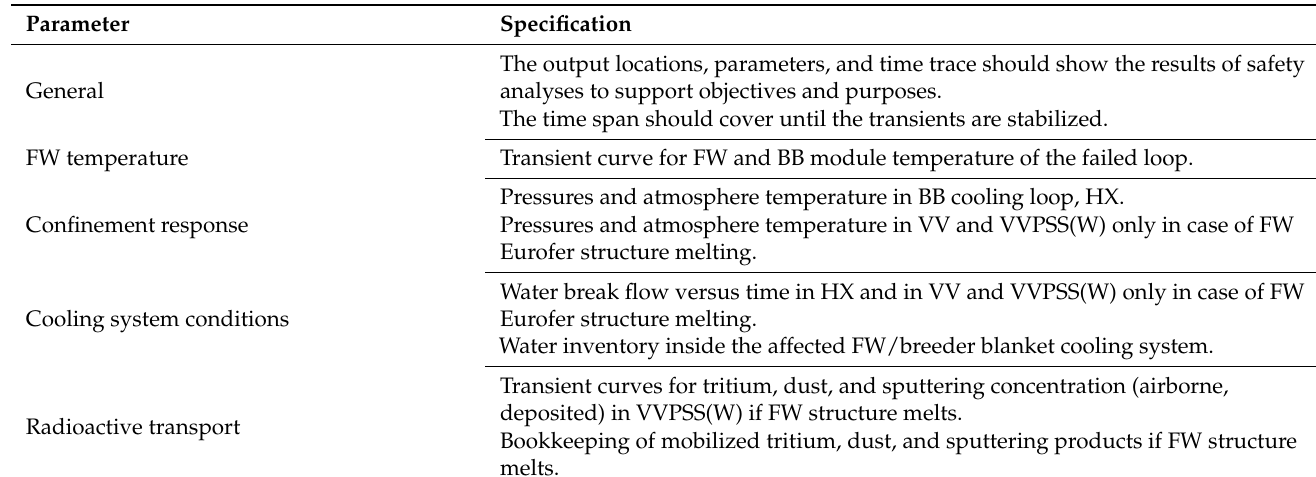
Table 10. Expected results from the analysis of the accidental